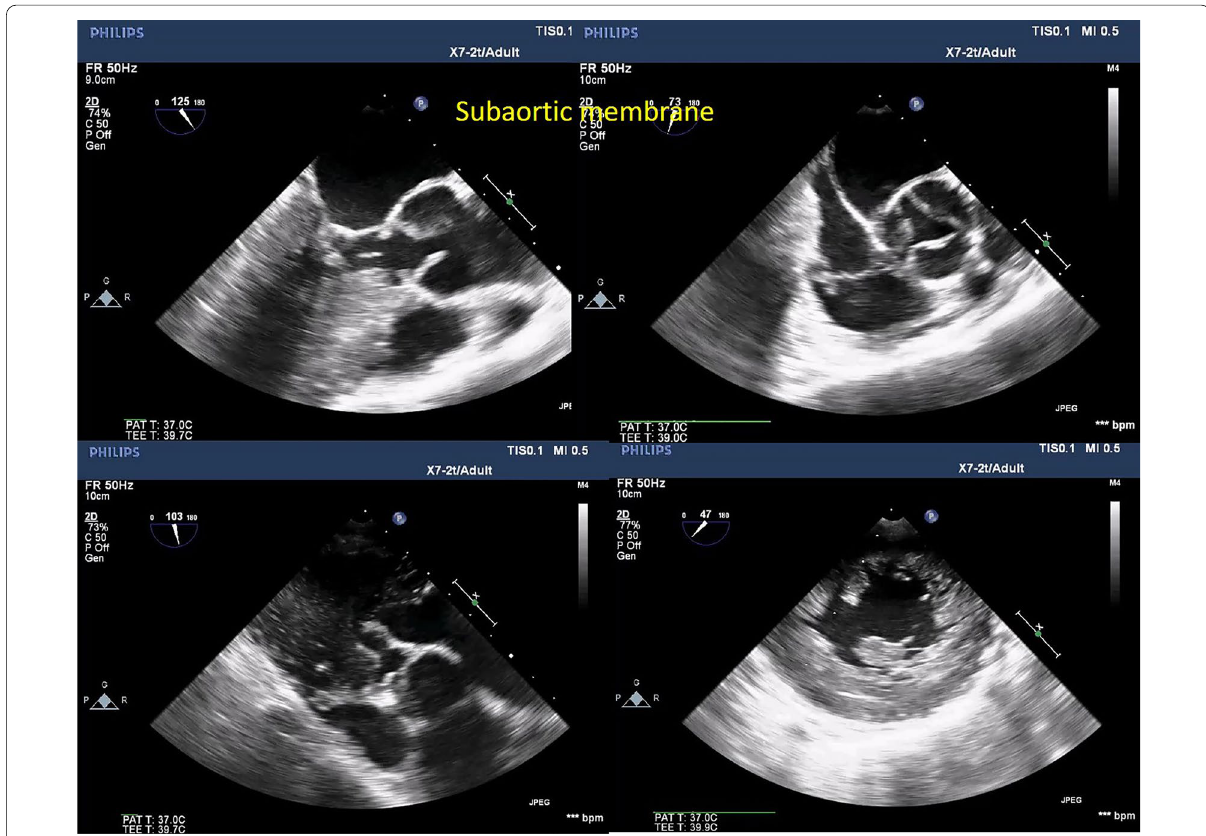
Fig. 13 Right upper panel, 2D TOE (ME aortic long‑axis view) shows small rims of the subaortic membrane seen immediately adherent to the aortic cusps. Left upper panel, 2D TOE (ME aortic short‑axis view) shows the trileaflet aortic valve. Right lower panel, 2D TOE (TG aortic long‑axis view) shows a small tunnel of the LVOT. Left lower panel, 2D TOE (TG short axis of the LV) shows hypertrophy of the left ventricle and papillary